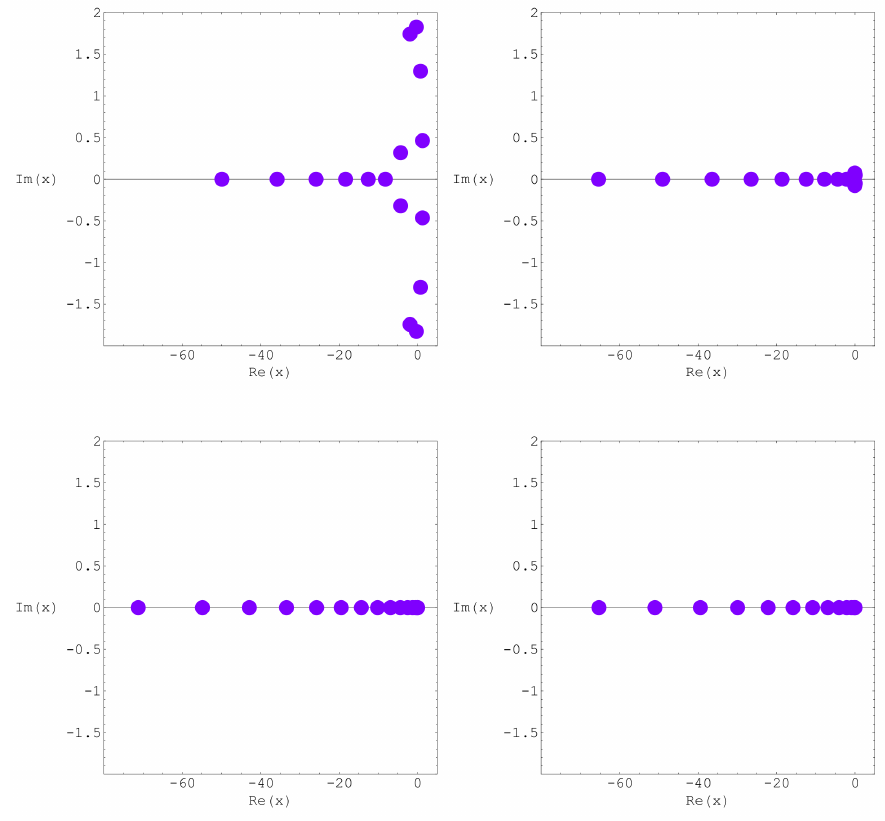
Figure 2. Zeros of G n ( x , r , β ) =